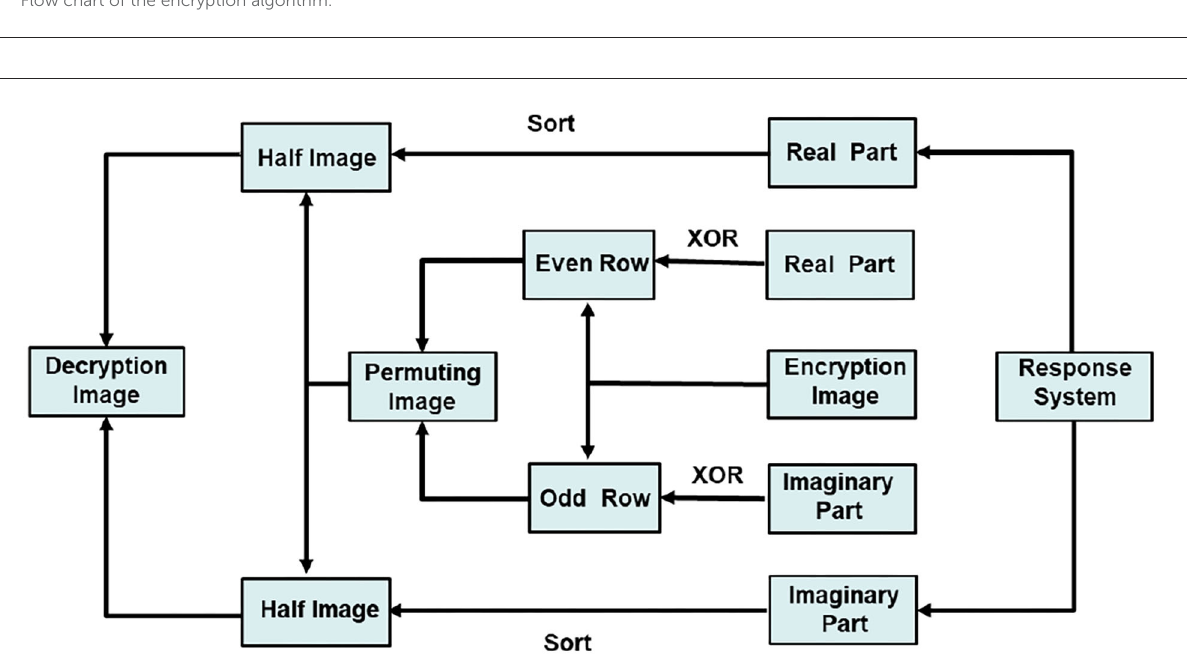
FIGURE10 Flow chart of the decryption